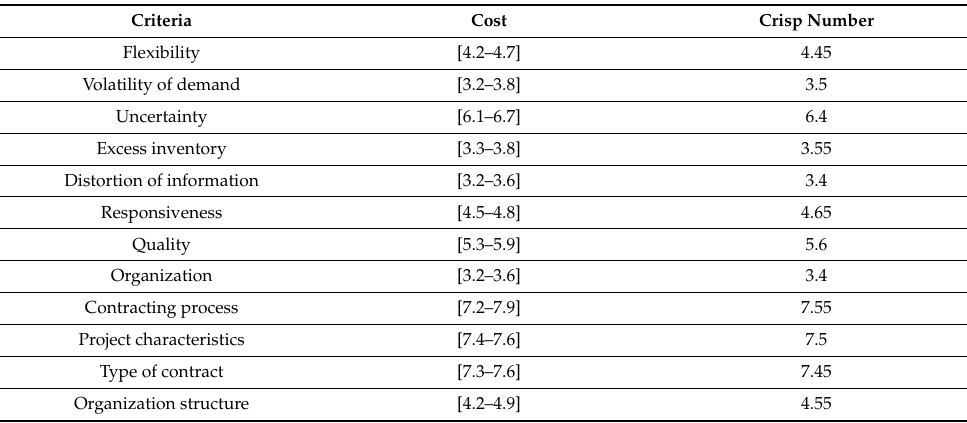
Table 7. Worst criteria, DM